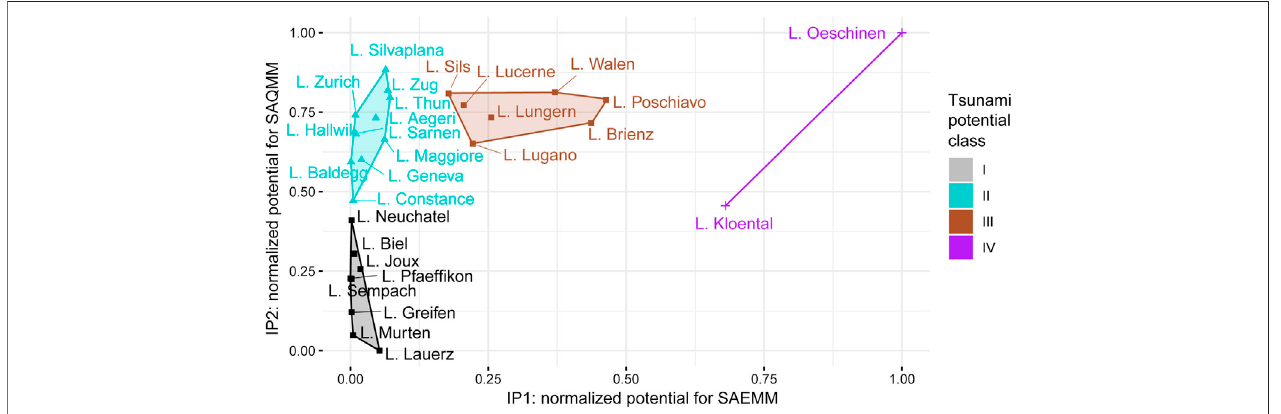
FIGURE 3 | Clusters of lakes according to IP1 and IP2 values, depicting the potential main tsunami potential classes.